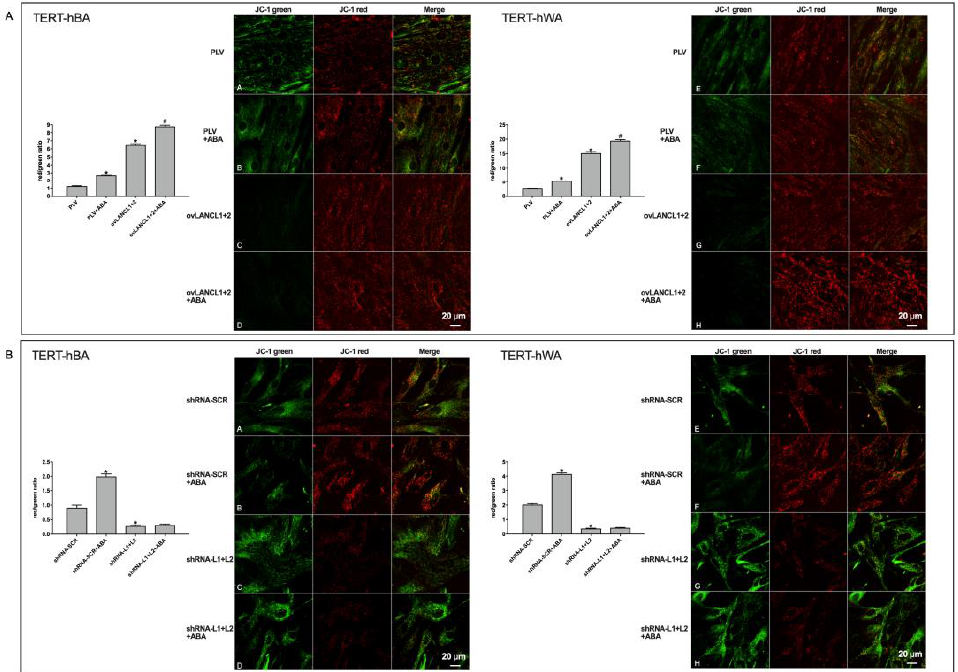
Figure 8. LANCL1/2-expression levels control the mitochondrial proton gradient in human white and brown adipocytes. Fully differentiated TERT-hBA and TERT-hWA cells overexpressing LANCL1 and LANCL2 (ovLANC1+2), or double-silenced for the expression of both proteins (shRNA-L1+L2), and their respective controls, cells infected with the empty vector (PLV) or cells infected with the scrambled silencing sequences (shRNA-SCR), were loaded with the ∆Ψ -sensitive ratiometric fluorescent dye JC-1, and cultured/incubated for 4 h without or with 100 nM ABA. Representative confocal microscopy images of brown (left panels) and white (right panels) adipocytes overexpressing LANCL1/2 ( A ) or silenced for both proteins ( B ). An increase in red fluorescence indicates a higher ∆Ψ. The histograms show the mean ± SD of the red/green fluorescence ratio calculated in at least 3 microscopic fields for each experiment. * p < 0.01 relative to untreated control cells and # p < 0.05 relative to ABA-treated control cells by unpaired t -test.